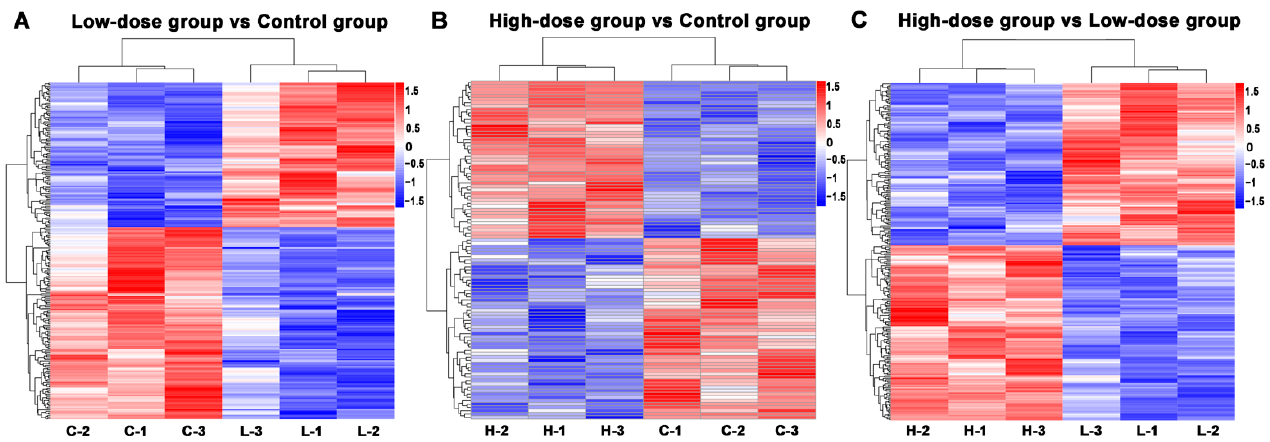
Figure 3. The heatmaps of differentially expressed proteins (DEPs) between different groups. ( A ) low-dose group vs. control group. ( B ) high-dose group vs. control group; ( C ) high-dose vs. low-dose group. Red represents up-regulation and blue represents down-regulation.